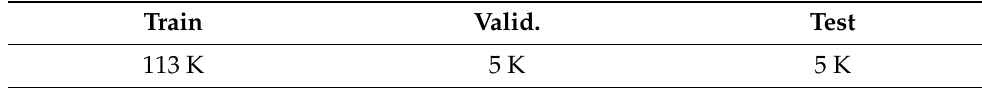
Table 2. Statistics of MS-COCO 2014 dataset.